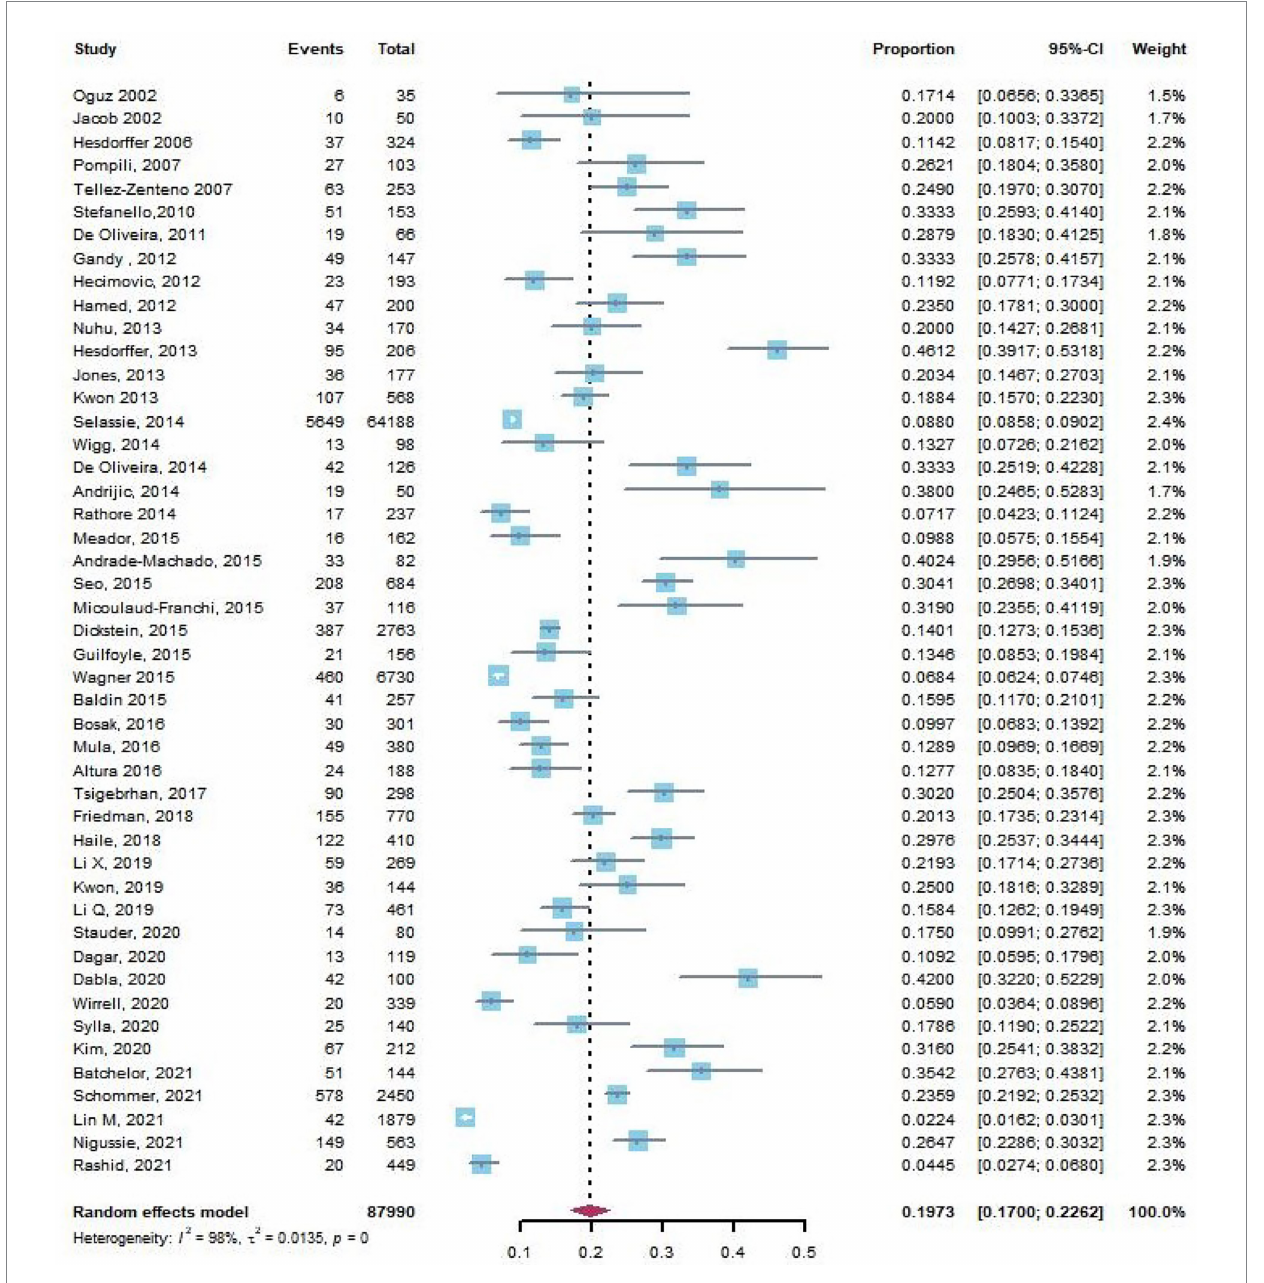
FIGURE 3 The crude rate of suicidal ideation in patients with